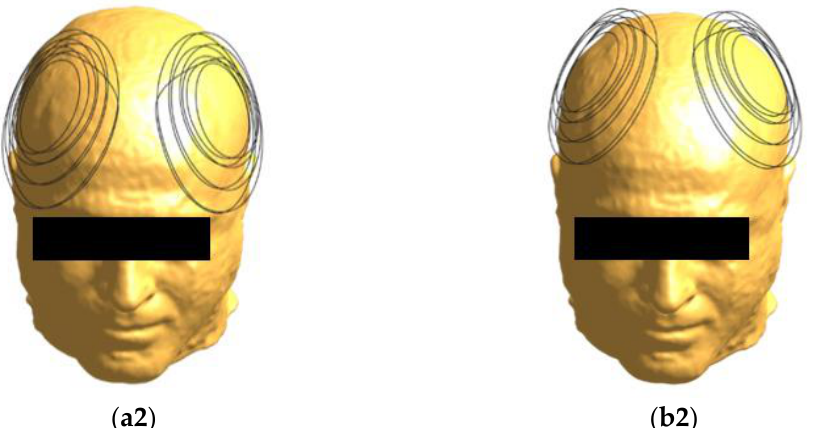
Figure 1. Coil positioning on the head model. The H7 coil, seen from different angles, is placed at frontal ( a1 , a2 ) and central ( b1 , b2 ) positions.